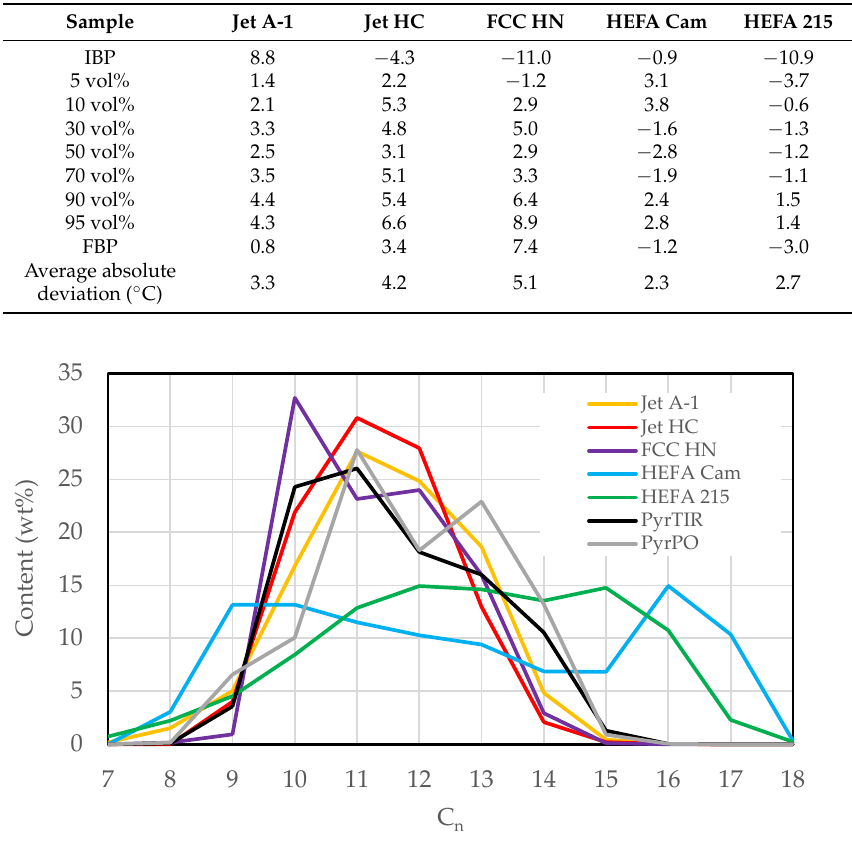
Figure 3. Distribution of hydrocarbons in the samples studied by carbon number.